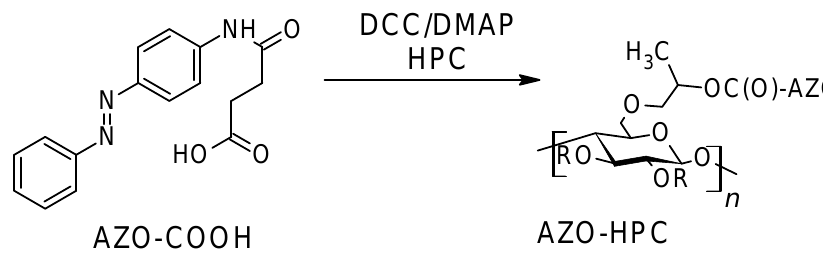
Figure 12. Synthetic pathway for AZO-HPC formation.